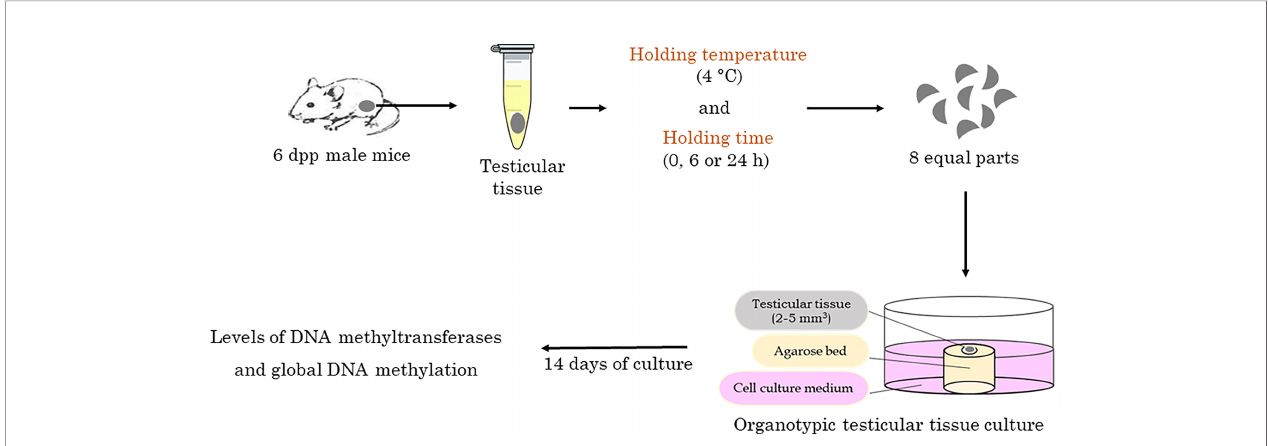
FIGURE 1 | Flowchart of the study. Experimental outline to assess the impact of short-term hypothermic holding on epigenetic integrity of the testicular